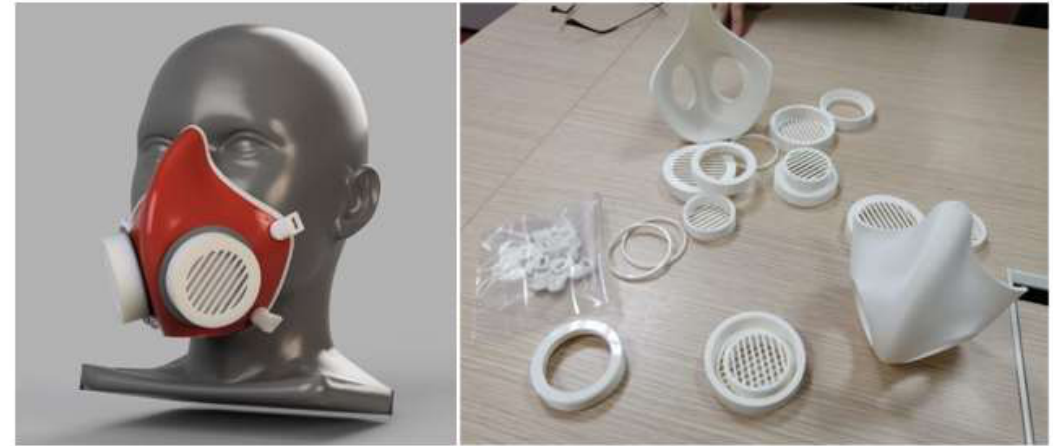
Figure 3. A 3D representation and printed GrabCAD reusable facemask [47].